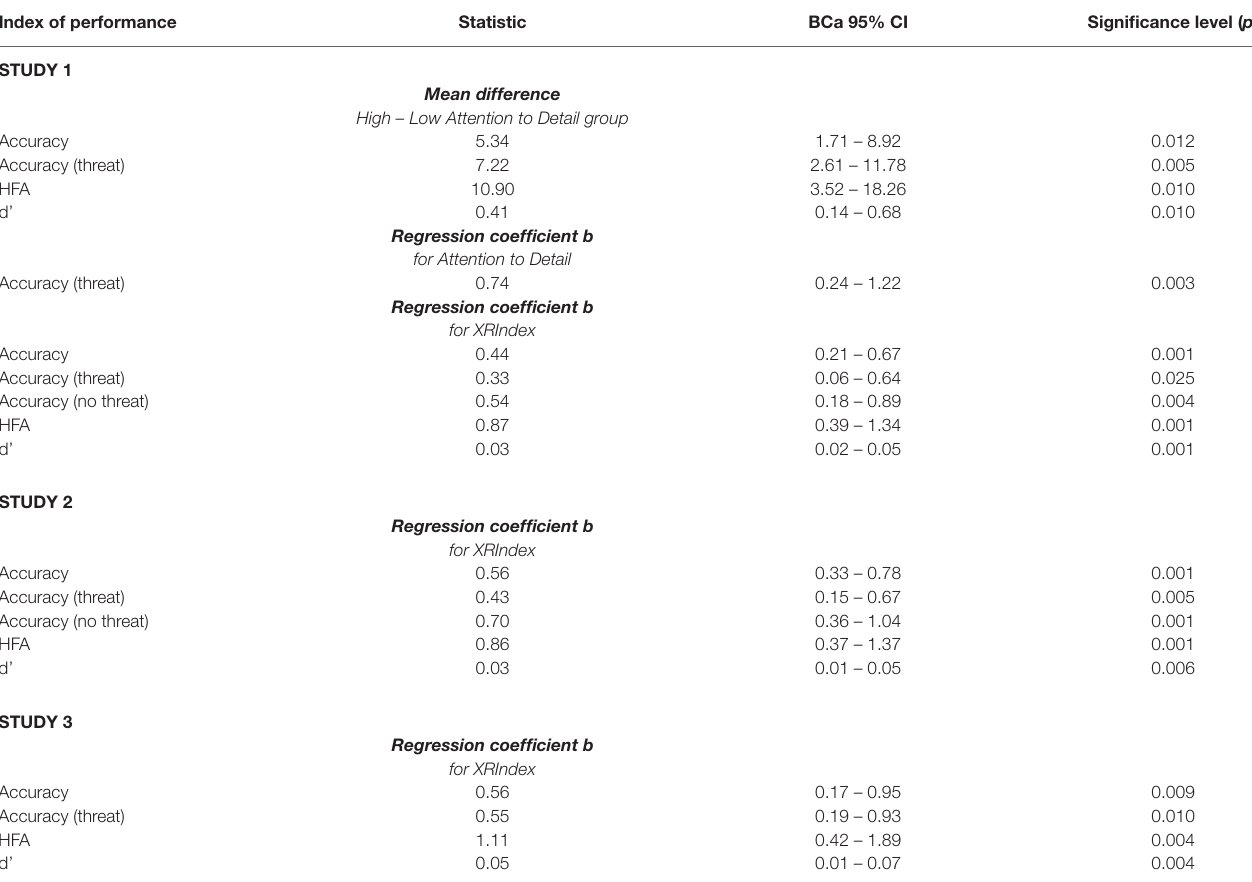
TABLE 2 | Robust statistics, Bias Corrected and accelerated (BCa) 95% confidence intervals (CIs) and significance levels for indices of performance with crucial significant parametric tests in Study 1, Study 2 and Study